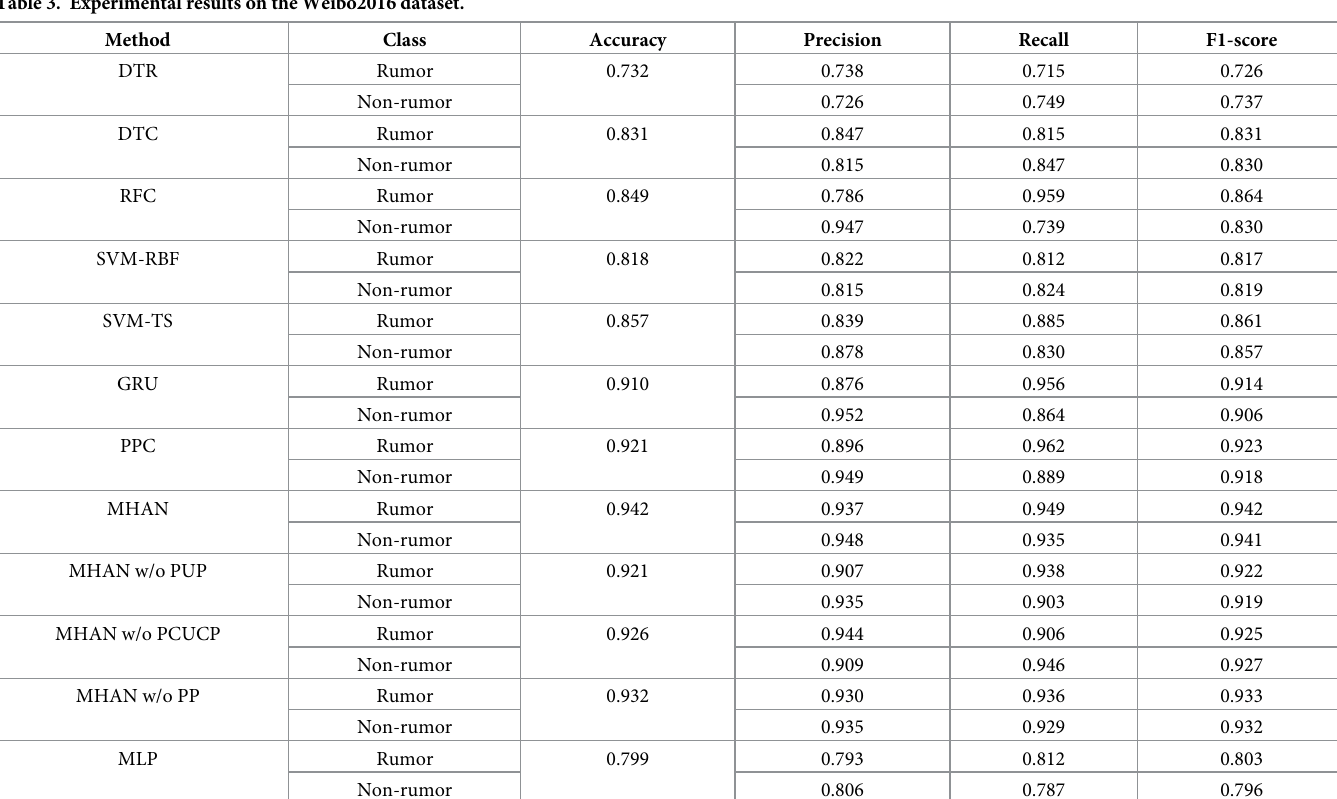
Table 3. Experimental results on the Weibo2016 dataset.